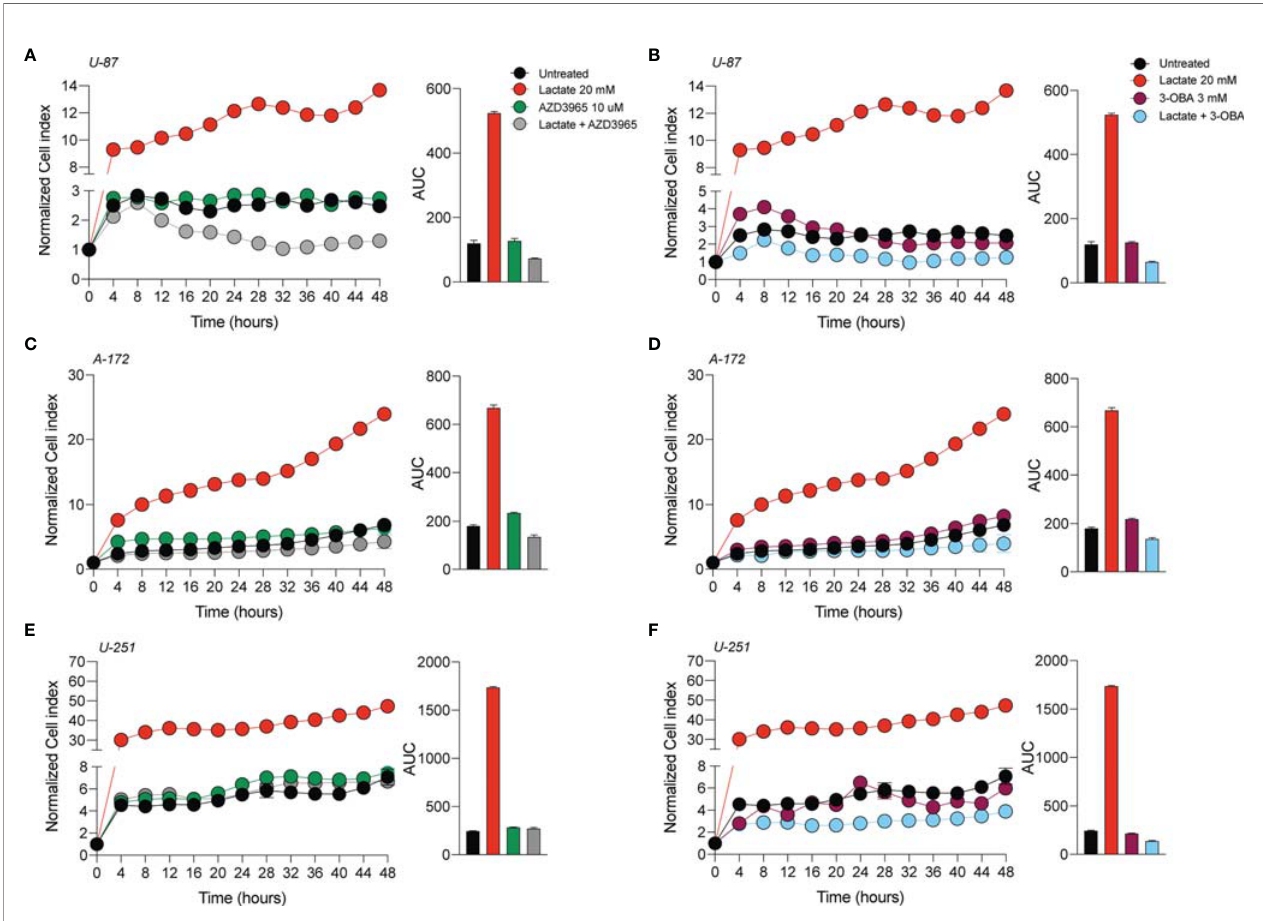
FIGURE 2 | AZD3965 and 3-OBA reduced glioblastoma cell proliferation. (A – F) Real-time cell proliferation monitoring in U-87 MG cells (A, B) , A-172 cells (C, D) , and U-251 cells (E, F) using the xCELLigence system following treatments with lactate (20 mM), AZD3965 (10 m M), and 3-OBA (3 mM). The cell index values were normalized at the time of pharmacological treatments in order to obtain a normalized cell index. Each line expresses the average of four different